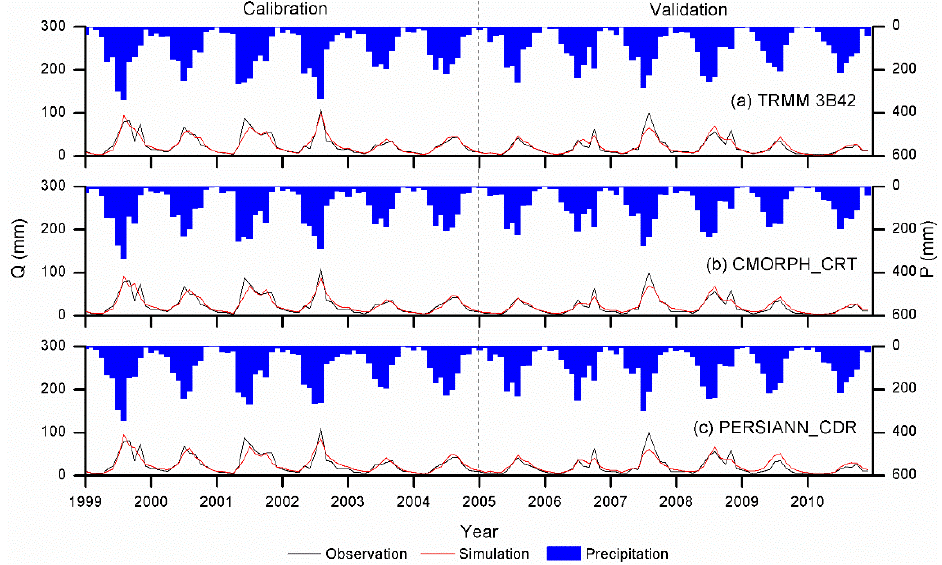
Figure 10. Daily discharge flow duration curves (FDCs) for observations, TRMM 3B42 simulation, CMORPH_CRT simulation, and PERSIANN_CDR simulation under Scenario II.